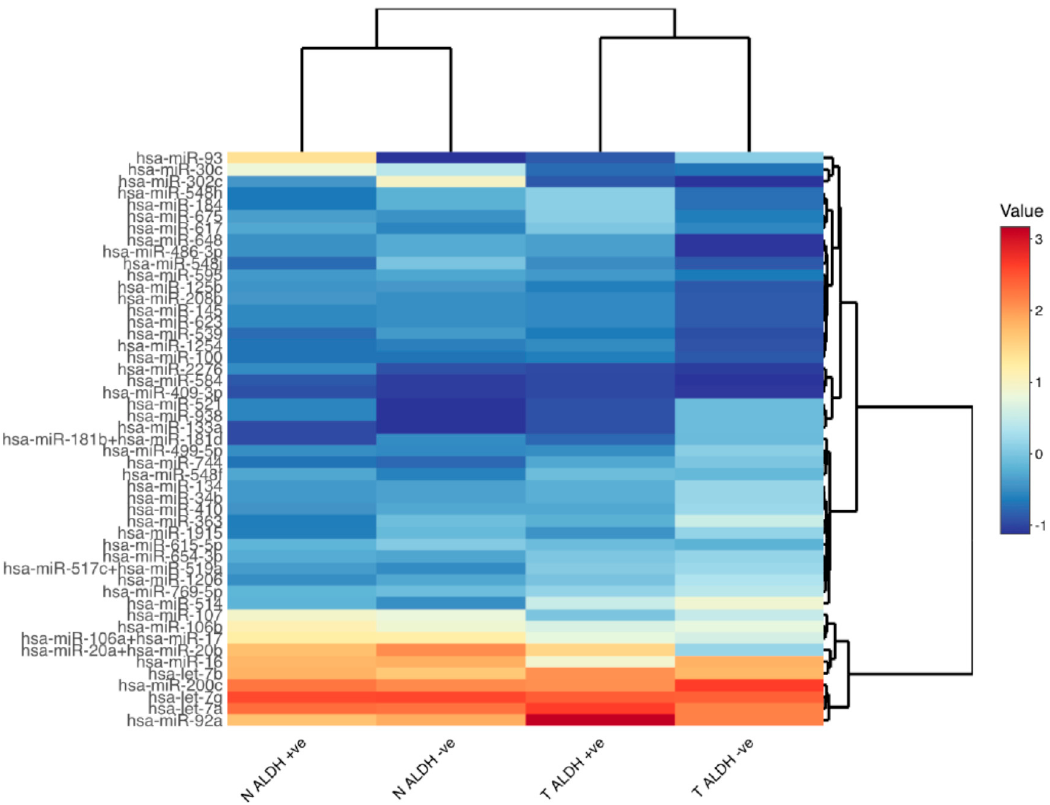
Figure 2. Differential expression of microRNAs in normal and tumor ALDEFLUOR positive and negative cells. This figure shows a focused heatmap for the subset of miRNAs based on statistical analysis (cuto ff of p < 0.1) of all patient cases assessed by Nanostring profiling. The results are expressed as the average of normalized counts for the four types of sorted cell samples, (ALDH-positive and -negative cells for normal (N) and tumor (T)), which is converted to log2 and scaled to the mean of each sample. The list of differentially expressed miRNAs shown in Figure 2 is given in Supplementary Table S2.